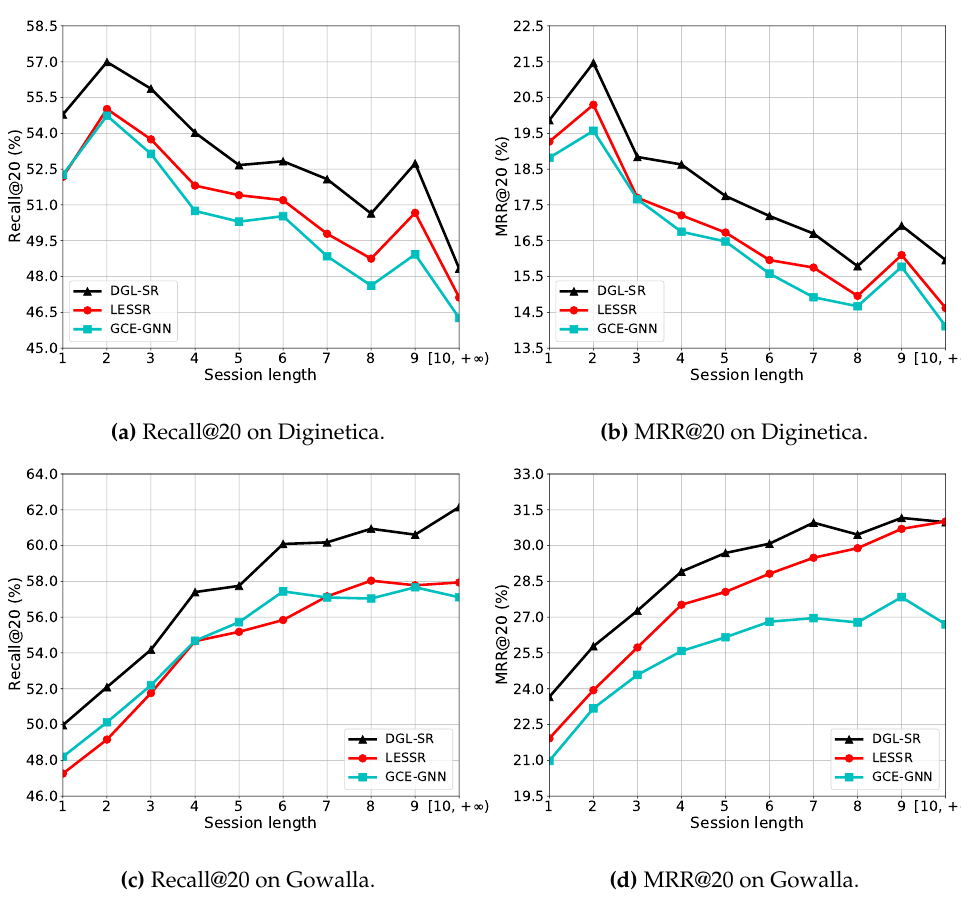
Figure 4. Model performance on sessions of different